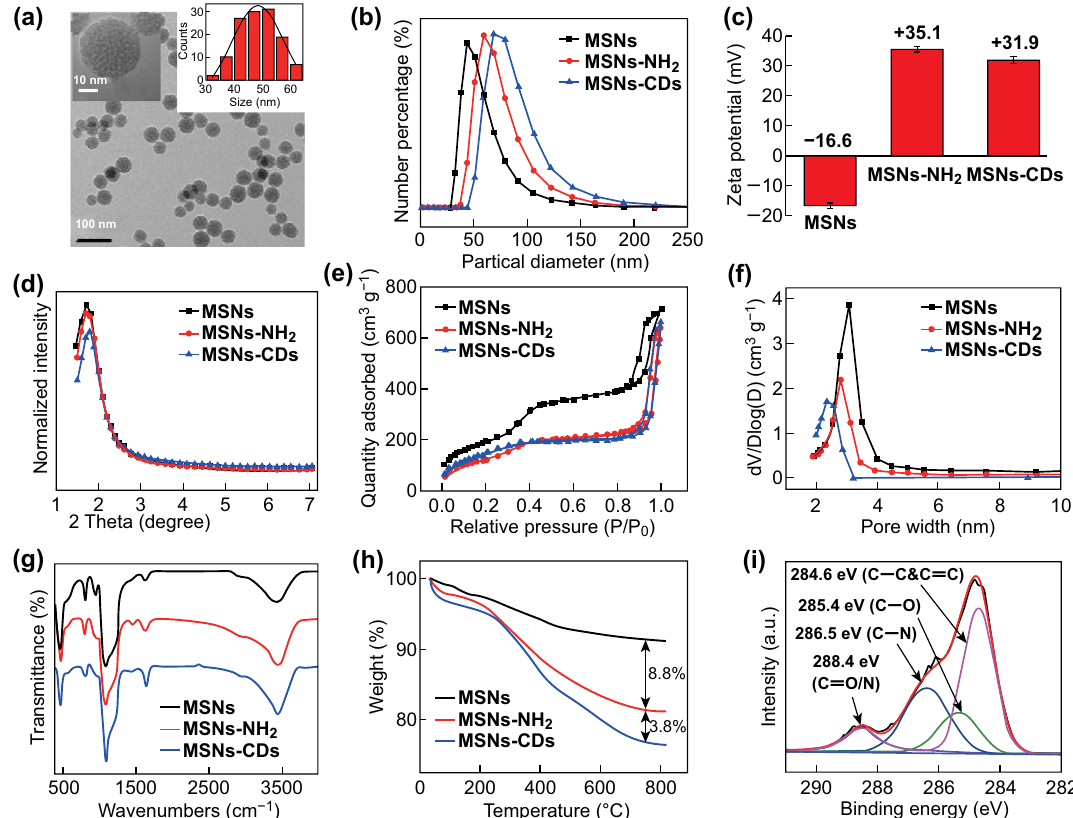
Fig. 1 a TEM image of the MSNs–CDs nanohybrid (inset: high-resolution image and size distribution of MSNs–CDs). b Hydrodynamic diam- eter distributions, c zeta potentials, d small-angle XRD patterns, e N 2 adsorption–desorption isotherms, f pore size distribution curves, g FT-IR spectra, and h TGA curves of MSNs, MSNs–NH 2 , and MSNs–CDs. i High-resolution C 1 s XPS spectrum of the MSNs–CDs nanohybrid and